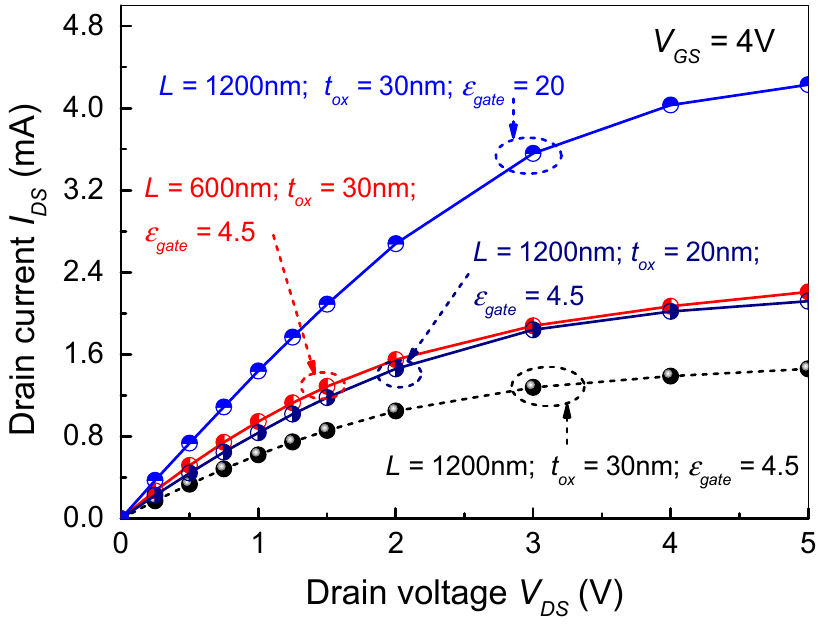
V GS =2V Solid lines: without SHE Dash lines: with SHE Figure 10. Output characteristic curve of vertical MOSFETs with, and without, consideration of the SHE. Further, the influences of geometric parameters on the performance of the proposed vertical MOSFET are investigated, with some results illustrated in Figure 11. It can be ob- served that the saturation current of the MOSFET is improved with decreasing channel length ( 𝐿 ) and gate oxide thickness ( 𝑡 (cid:3042)(cid:3051) ), and with the increasing relative permittivity of gate oxide ( 𝜀 (cid:3034)(cid:3028)(cid:3047)(cid:3032) ). However, the increase in drain current could result in larger power consumption and then aggravate SHE. The electrothermal coupling simulations have been carried out, and the maximum temperatures in MOSFETs are presented in Figure 12. Consistent with the saturation current, the maximum temperature in MOSFETs increases with the decrease in channel length and gate oxide thickness. It can also be observed that the maximum temperature in MOSFET with 𝐿 = 1200 nm , 𝑡 (cid:3042)(cid:3051) = 30 nm , and 𝜀 (cid:3034)(cid:3028)(cid:3047)(cid:3032) = 20 is lower than those in MOSFETs with 𝐿 = 600 nm , 𝑡 (cid:3042)(cid:3051) = 30 nm , and 𝜀 (cid:3034)(cid:3028)(cid:3047)(cid:3032) = 4.5, and with 𝐿 = 1200nm , 𝑡 (cid:3042)(cid:3051) = 20 nm , and 𝜀 (cid:3034)(cid:3028)(cid:3047)(cid:3032) = 4.5, although it possesses largest saturation